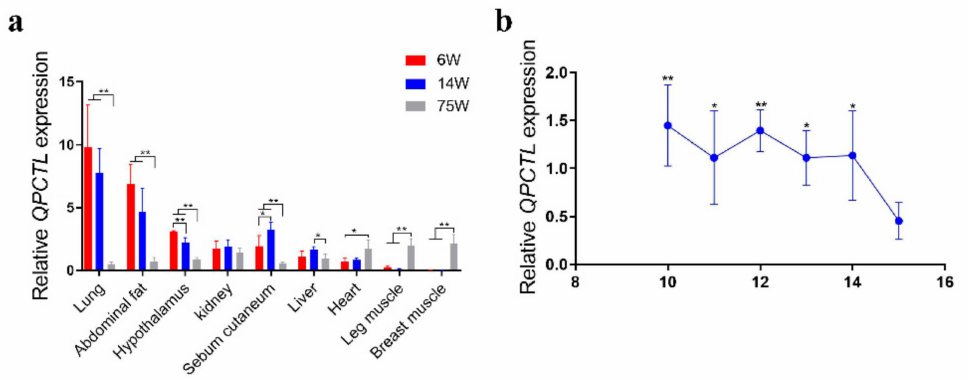
Figure 2. Relative expression levels of the QPCTL gene. ( a ) Relative expression patterns of QPCTL in different tissues and at different weeks of age in Gushi chickens ( n = 12). ( b ) Expression of the QPCTL gene in breast muscle at different embryonic stages in Xinghua chickens ( n = 18). * p < 0.05; ** p < 0.01.